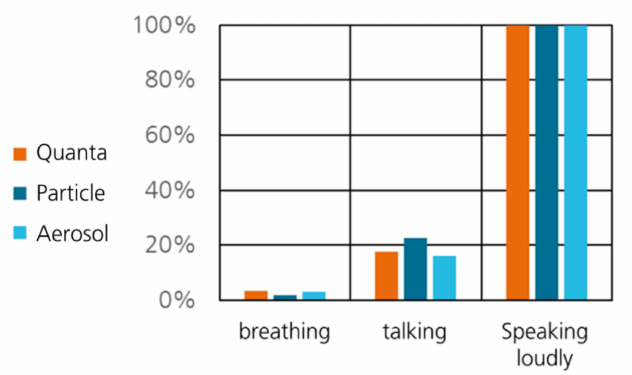
Figure 4. Relative comparison of approaches to describe the emitter as a quanta, particulate or aerosol source.